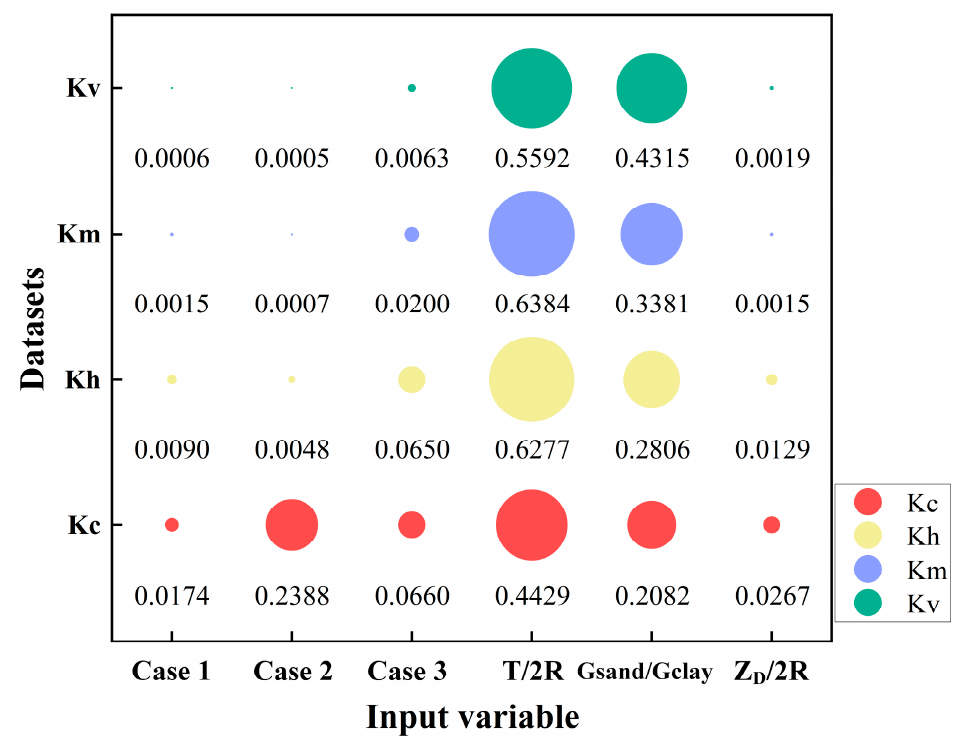
Figure 11. Variable importance score for four datasets. Figure 12 analyzes how the features T/2R, G sand /G clay, and Z D /2R affected the prediction for the target variables K c , K h , K m , and K v . T/2R had the greatest influence on the stiffness coefficient and was negatively correlated with K h , K m , and K v . Within a certain T/2R range (normalized T/2R < 0.2), the values of K h , K m , and K v decreased rapidly with the increase in T/2R. When the value of T/2R was greater than 0.2, K h , K m , and K v tended to remain unchanged. While K c first increased and then decreased with the increase in the T/2R value, 0.1 was the critical value of K c change. Furthermore, we also found that G sand / G clay was positively correlated with K c , K h , K m , and K v ; with the gradual increase in the feature value of Z D /2R , K c , K h , K m , and K v changed little, indicating that Z D /2R was relatively less important for the stiffness coefficient. Figure 13 further illustrates the interaction influence of input variables on the output, taking the K c dataset as an example. There is a strong correlation among T/2R , G sand / G clay, and Z D /2R , and they affect the stiffness coefficient in a coupled way. For example, when T/2R was less than 0.25 and G sand / G clay was more than 20, the model tended to predict a large K c . A large K c was also observed when G sand /G clay was greater than 30 and the Z D /2R was in the range of 0–0.5. The above analysis provided a certain reference for improving the stiffness of the circular foundation.